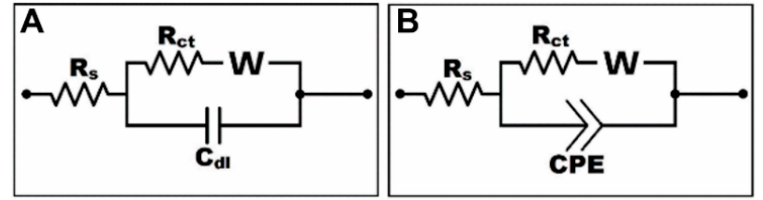
Figure 2. Randles equivalent circuit considering: ( A ) C dl and ( B ) CPE.